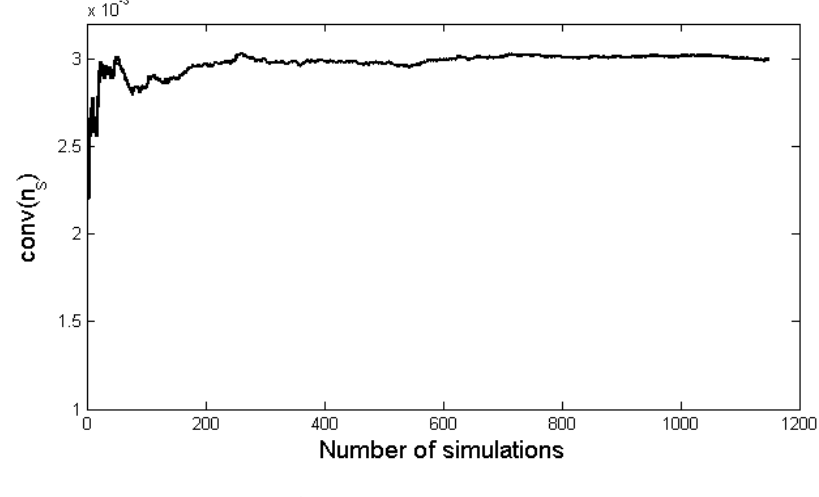
Fig. 3. Mean square